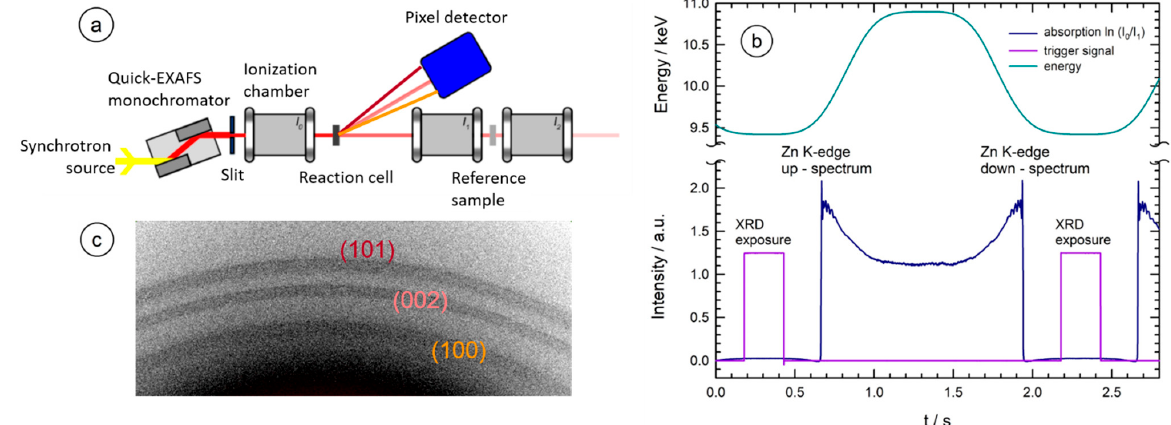
Figure 2. ( a ) Schematic representation of the experimental setup with the fast-scanning monochromator, the ionization chambers and the flat-panel detector arranged in forward-scattering geometry from the sample. ( b ) Continuous variation of the monochromator energy as a function of time, together with the measured absorption spectrum of the sample, and the trigger signal placed in the flat pre-edge region of the measurement. ( c ) Example of a diffraction pattern collected during the formation of ZnO nanoparticles in Zn(acac) 2 solution in 10 − 3 M NaOH (sample A) at a temperature of ca. 85 °C (t = 3200 s) within 250 ms of integration time. The (100)-reflection with a Bragg angle Θ B of Θ B ≈ 27.0° is located at the bottom of the active area of the pixel detector, the (002) with Θ B ≈ 29.3° in the center, and the (101) in the upper region with Θ B ≈ 30.8°, respectively, as also indicated by the colors in ( a ).